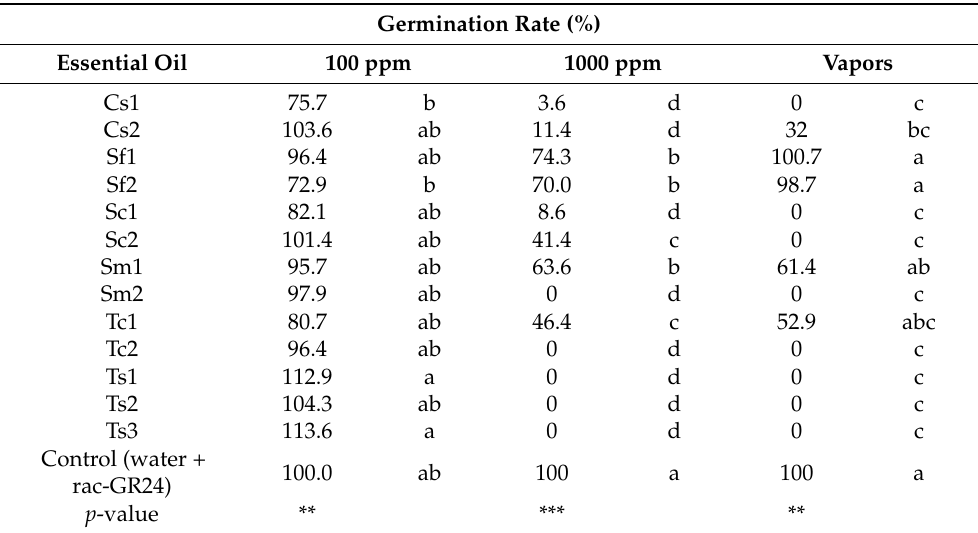
Table 7. Pearson correlation matrix between the chemical composition (%) of EO and the inhibitory biological activity: cress germination with EOs at 100 and 1000 ppm (C100 and C1000), tomato rad- icle growth with EOs at 100 and 1000 ppm (T100 and T1000), chlorophyll and carotenoid Table 6. Herbicidal effect on Phelipanche ramosa seed germination after 3 days of incubation with EOs applied in direct contact (100 and 1000 ppm) or as vapors (3 µ L). Data are expressed as mean of three replicates in comparison with the control (100%).